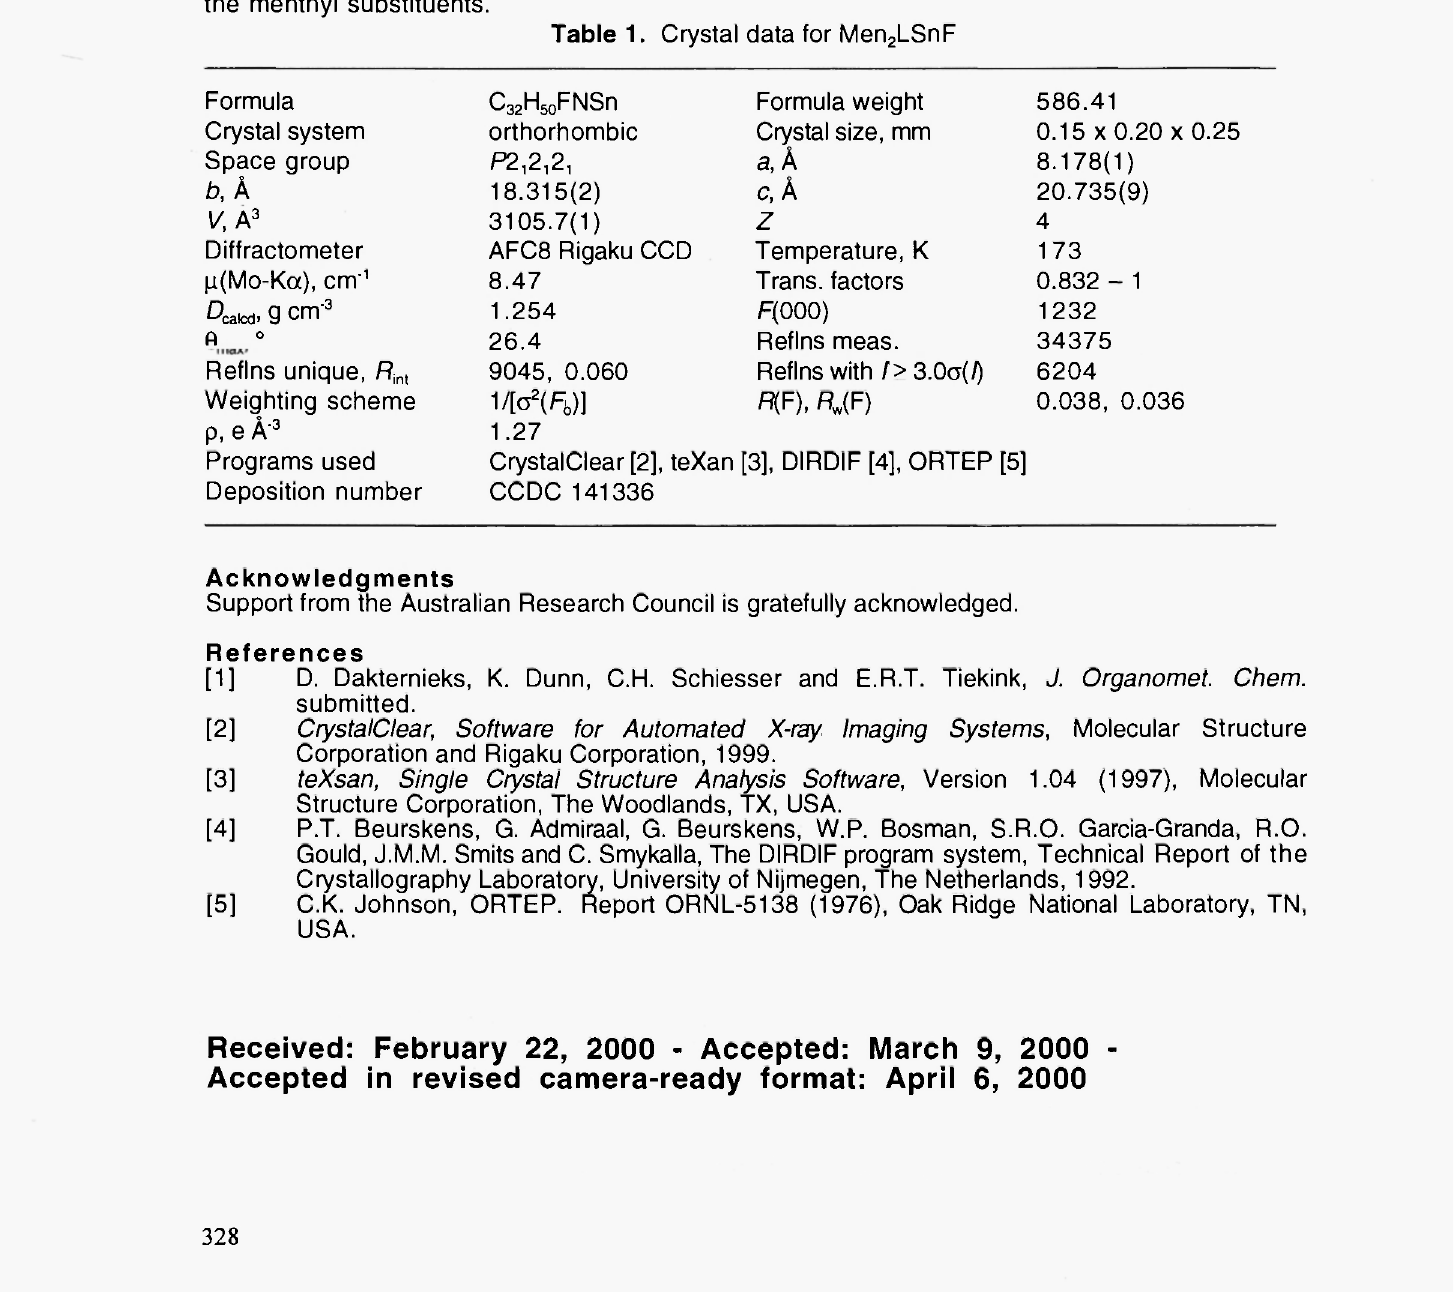
Table 1. Crystal data for Men 2